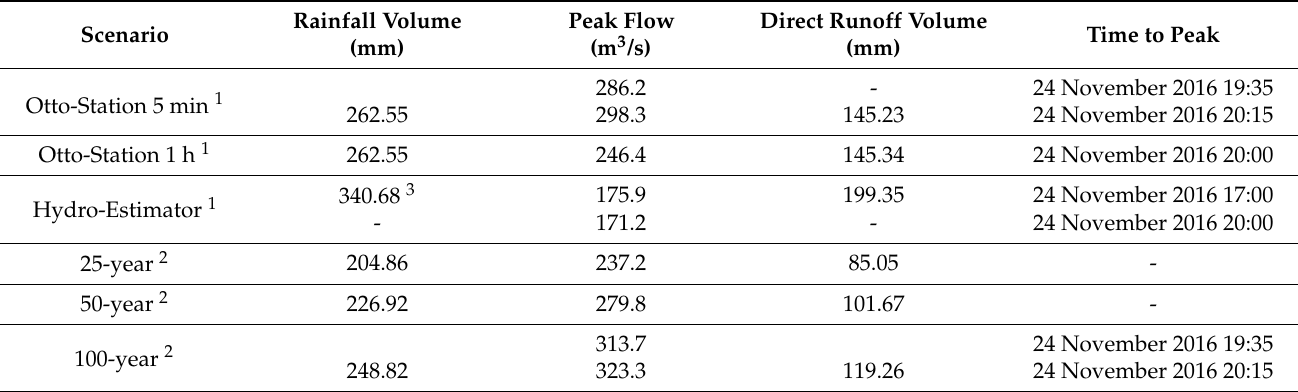
Table 4. Summary results from hydrologic simulations for each rainfall scenario